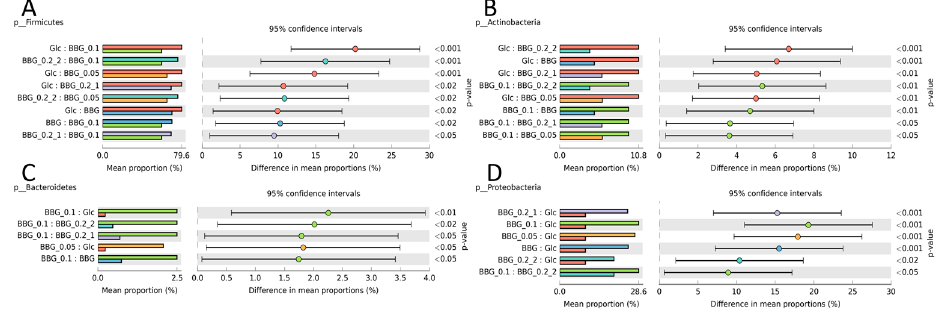
Figure 5. Significantly different taxa in phyla level identified using ANOVA (Tukey HSD post-hoc test) with Benjamini-Hochberg FDR multiple test correction. ( A ) Firmicutes; ( B ) Actinobacteria; ( C ) Bacteroidetes; and ( D ) Proteobacteria. These 4 major taxa accounted for 99.90 ± 0.07% of total taxa identified.